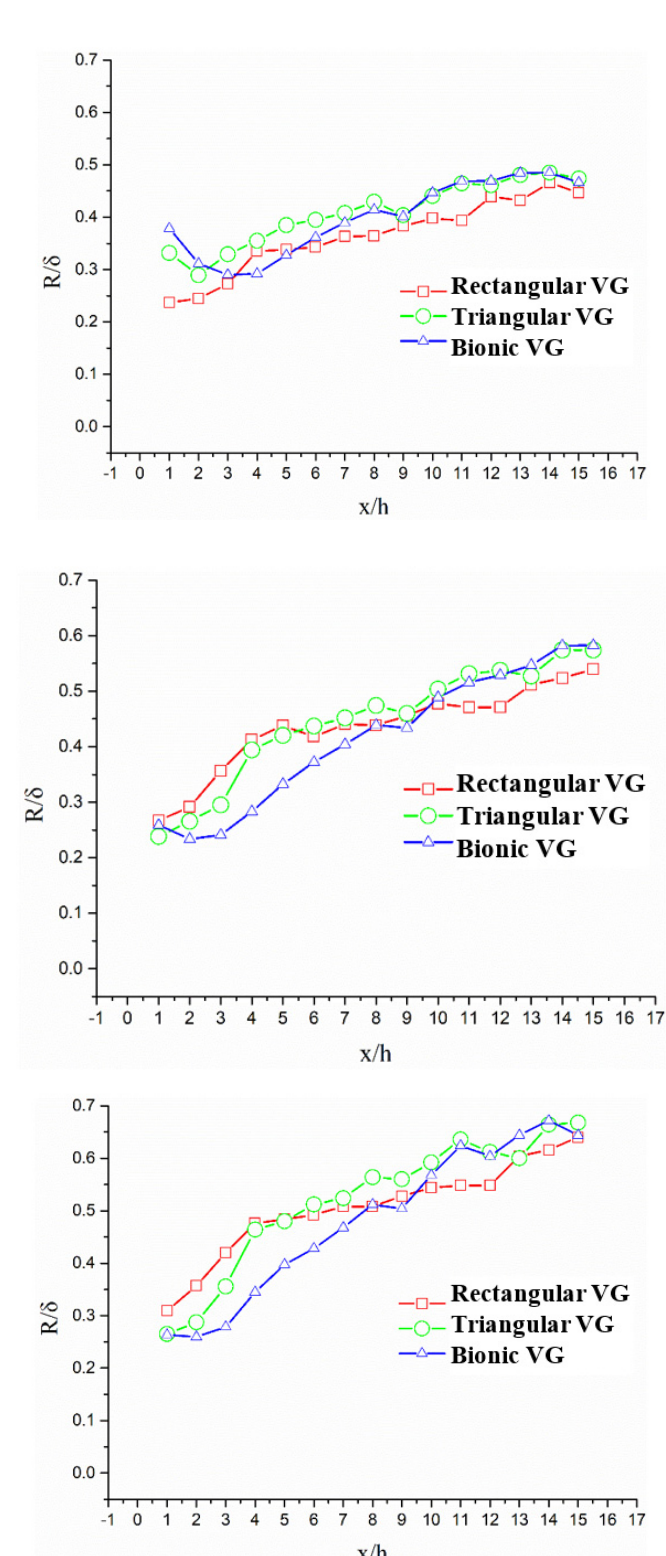
Figure 5. Vortex radius determined at a 0.9 confidence level.